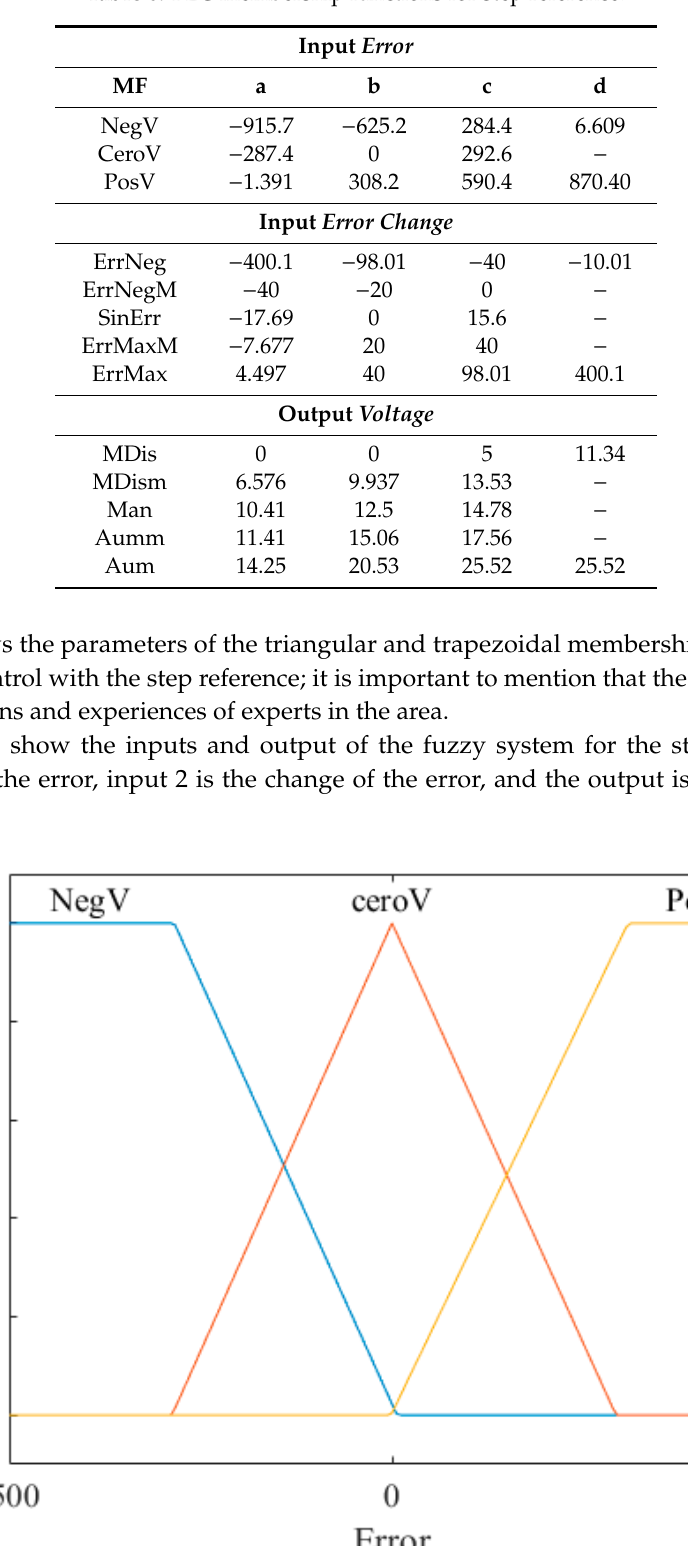
Table 6. FLC membership functions for step reference.